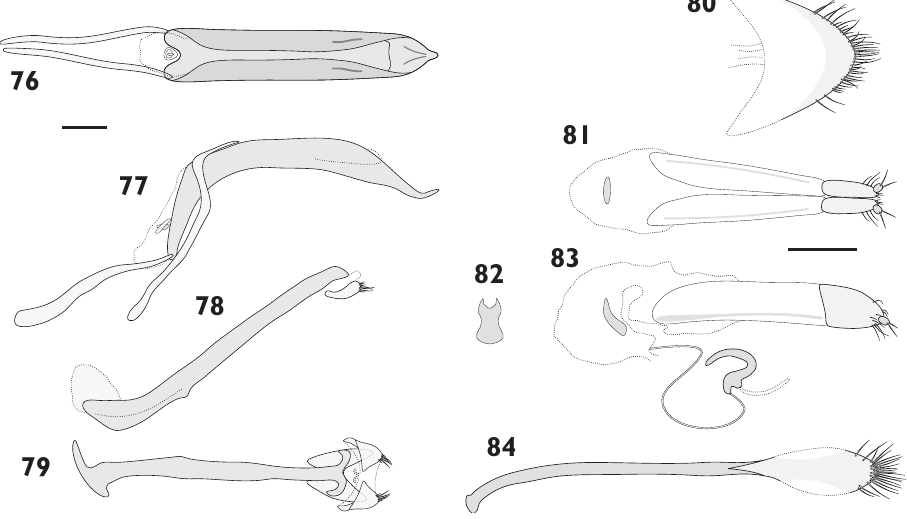
Figures 76–84. Genitalia of Austromonticola postinventus . 76 penis, dorsal view 77 aedeagus, lateral view 78 male hemisternites 8 and spiculum gastrale, lateral view (muscles between hemisternites 8 and basal plate indicated) 79 male hemisternites 8 and spiculum gastrale with basal plate, ventral view 80 fe- male tergite 8, dorsal view 81 ovipositor, dorsal view 82 bursal sclerite, anterior view 83 ovipositor and spermatheca, lateral view 84 female sternite 8, ventral view. Scale bars = 0.5 mm; 75–79 at same scale; 80–84 at same